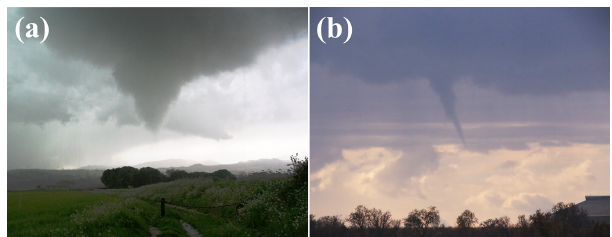
Figure 3. (a) Well-developed funnel cloud observed in Santa Eu- làlia de Ronçana (Catalonia) on 4 April 2010 (author: @Cal- abobosChaser), and (b) well-developed funnel cloud observed in Bellpuig (Catalonia) on 1 December 2017 (author: Edgar Aldana). In both cases no evident tornado was actually observed (i.e. touch- down) but nearby damage was reported, suggesting tornado occur- rence.